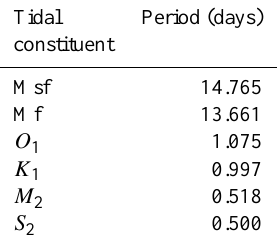
Table 1. Tidal constituents and their respective